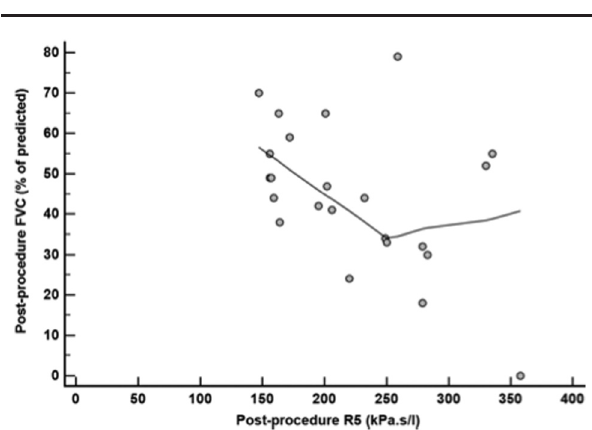
Scatter plot showing correlation between FVC and R5 post procedure in heterogeneous emphysema group.